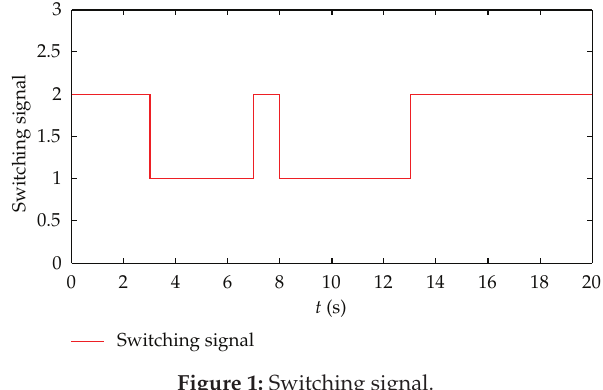
Figure 1: Switching signal.